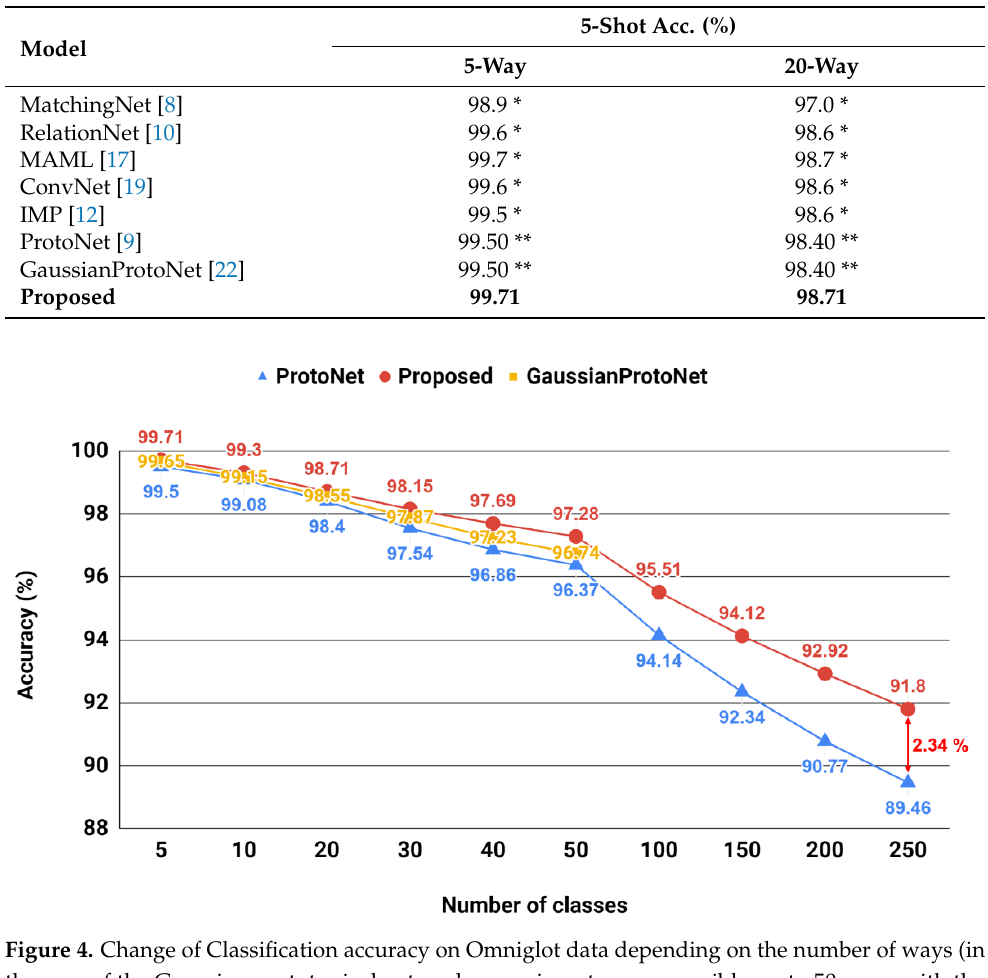
Table 1. The 5-shot classification accuracies on Omniglot data. The values marked with * are quoted from the original works [8,10,12,17,19], and the ones with ** are measured by experiments using codes provided by the authors [9,22].